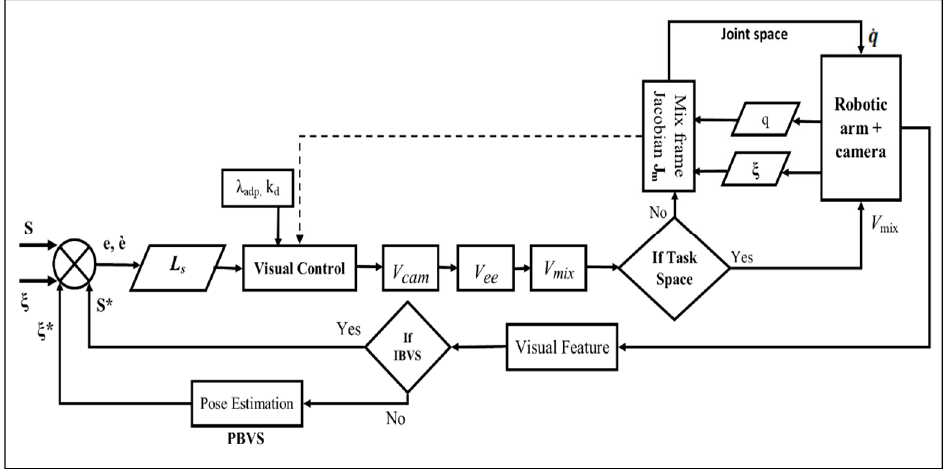
Figure 4. Block diagram of the proposed mix frame visual servo control framework.